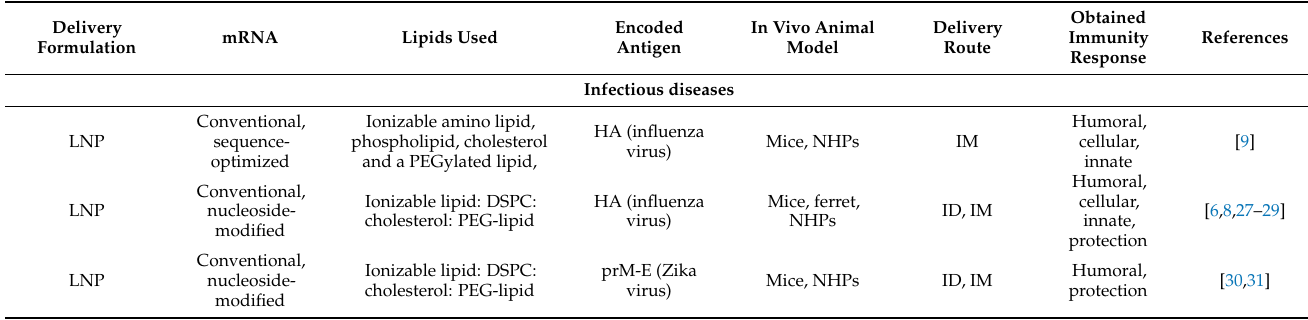
Table 1. mRNA vaccines in various lipid-based formulations developed for preclinical studies against infectious diseases and